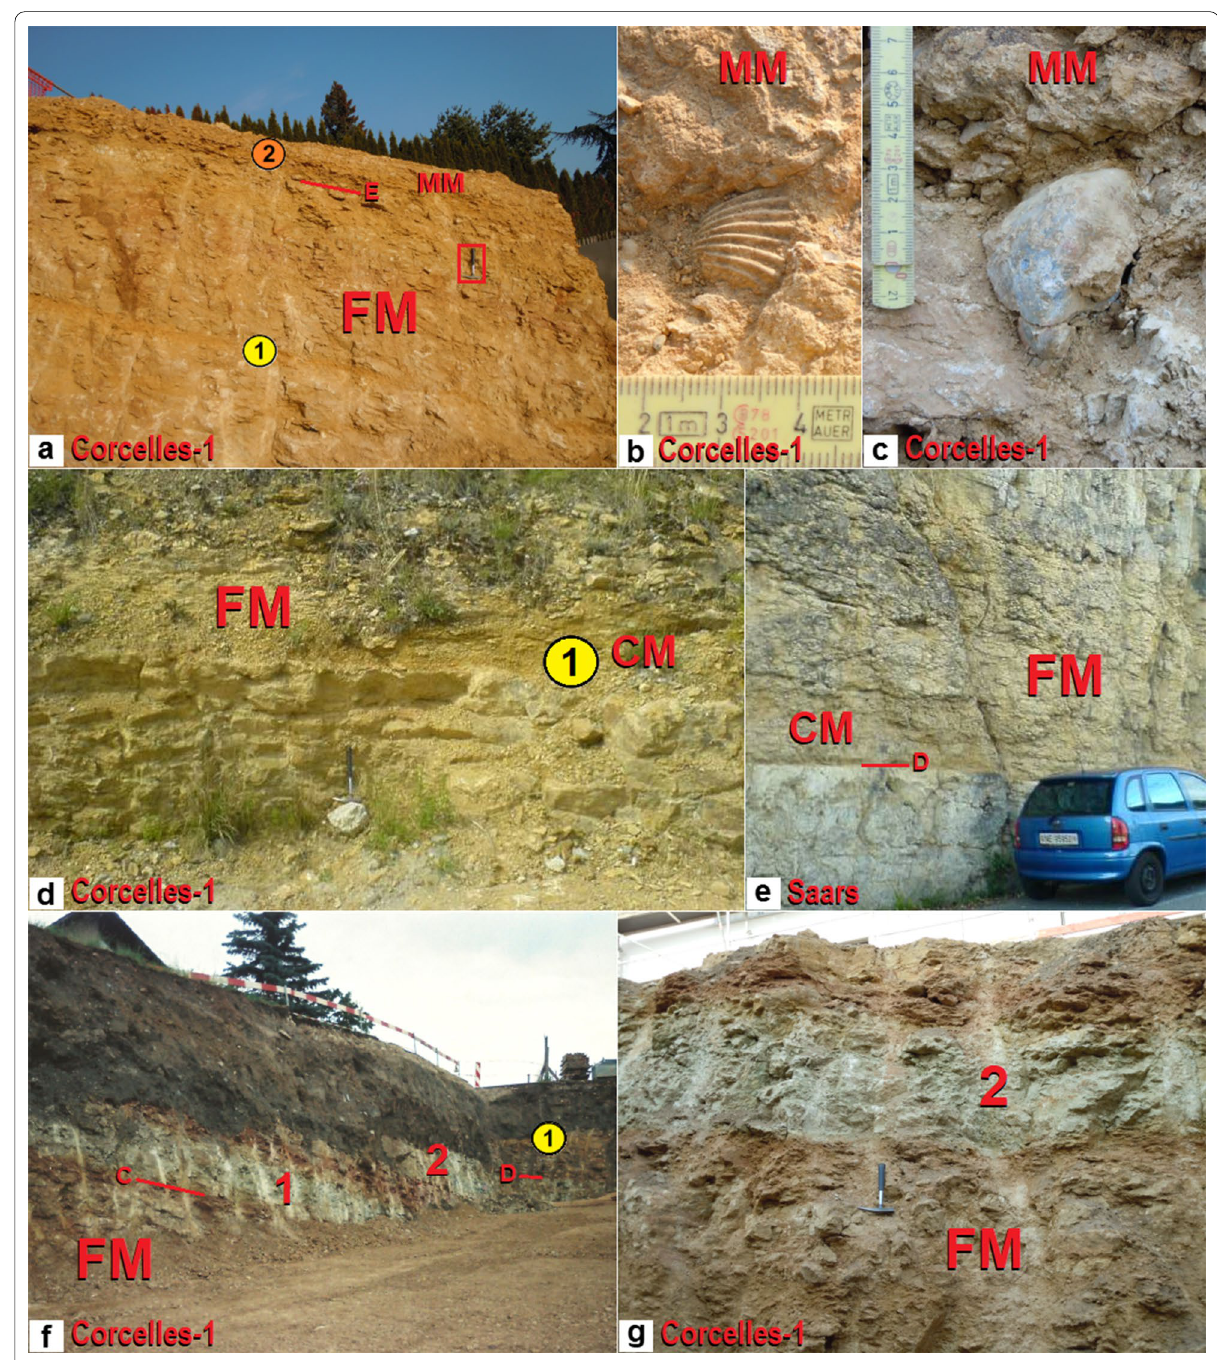
Fig. 6 Saars Formation of the Neuchâtel area (central Jura Mountains). a – d , f , g Corcelles‑1 section: a – c Upper part with ( b ) holotype of Glosseudesia inexpectata Mojon, n. sp. and ( c ) ostreid bivalve Exogyra (Aetostreon) latissima (Lamarck, 1801) in situ ; d , f , g Lower part with glauconite‑rich beds 1 and 2. e Les Saars‑Le Mail section. Captions: FM: Falaises Member; CM: Corcelles Marls (lithostratigraphic bed); MM: Montcherand Member. For the reported discontinuities (C, D, E) and ostracod assemblages (colored circles 1, 2), see Figs. 10 and 11. The hammer ( a : red frame; d , g ) is 31.5 cm